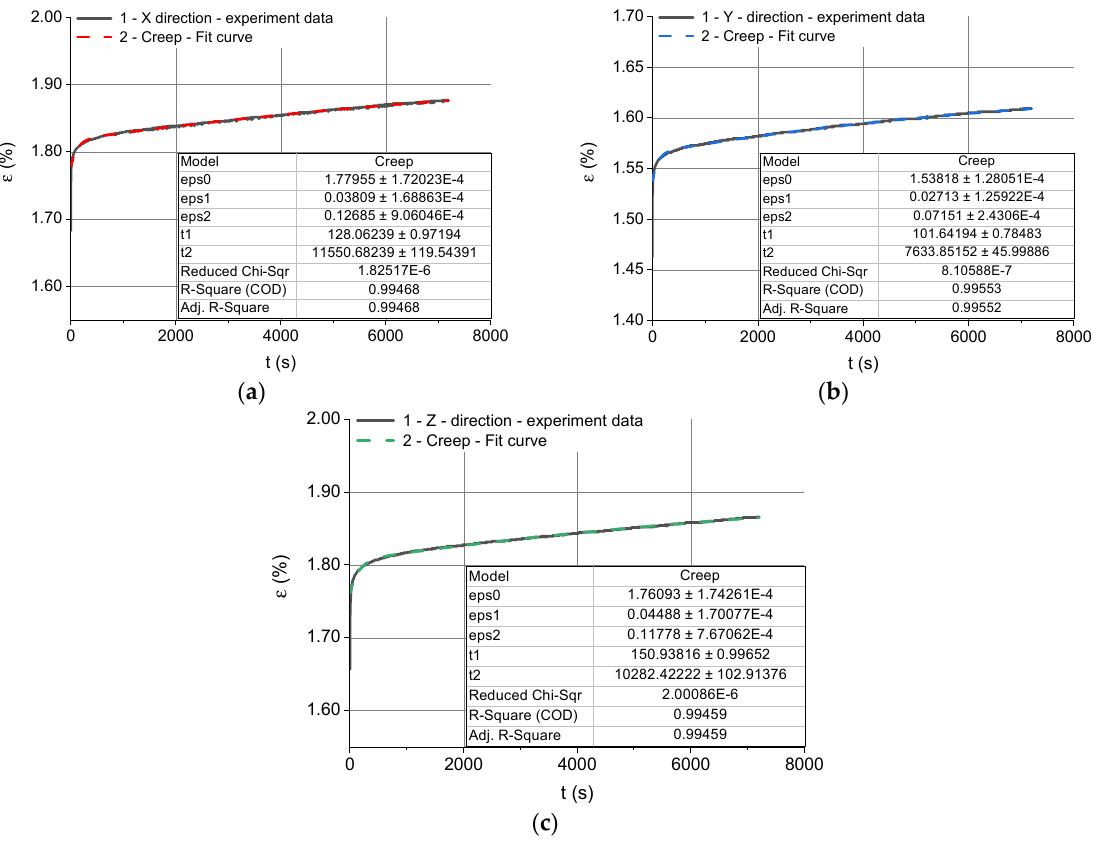
Figure 8. The results of the creep tests with the best fit curves. 1—experimental creep curves, 2—creep